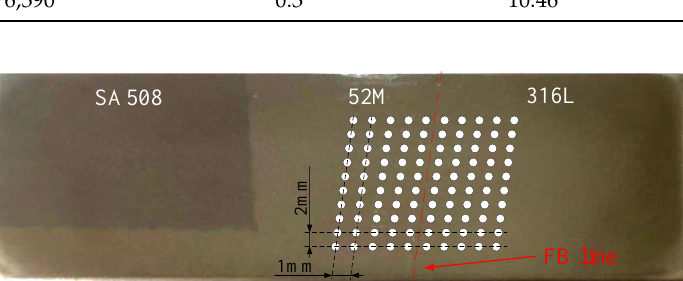
Figure 3. Vickers hardness test samples and hardness test points.